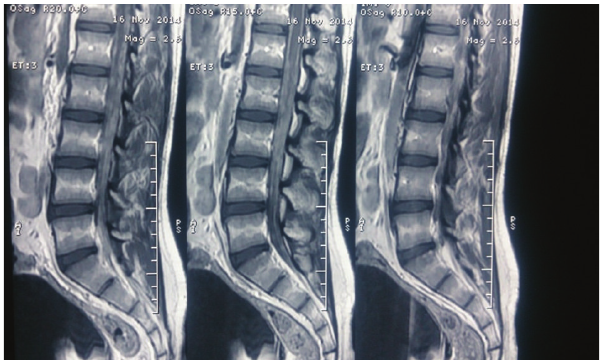
Figure 6: Spine MRI showing drop metastases in the lumbosacral spine.